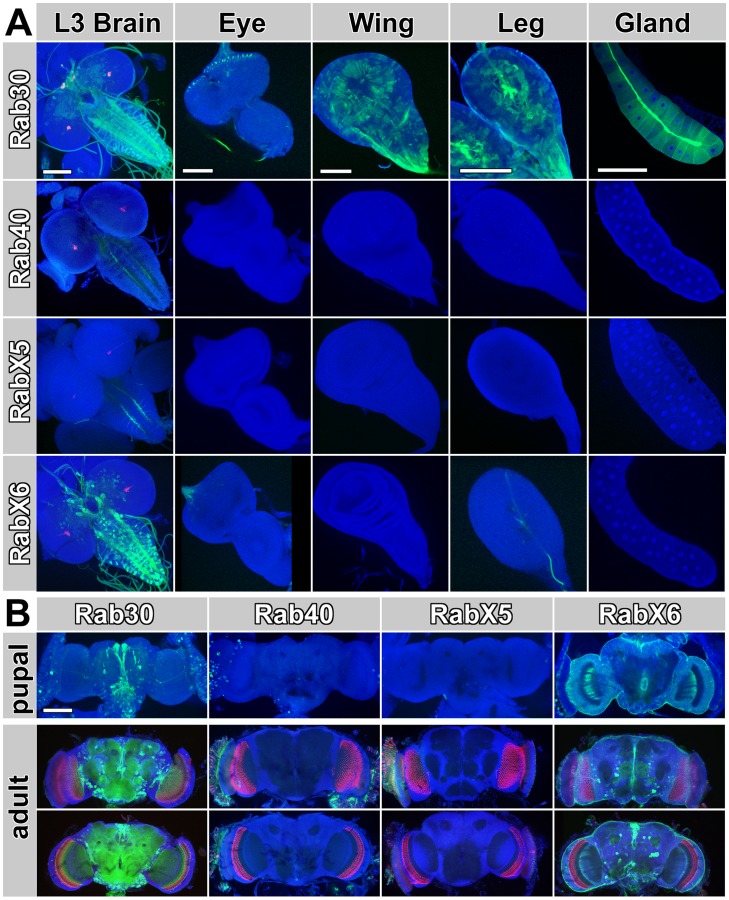
Cellular Expression Analysis of rab30-Gal4, rab40-Gal4, rabX5-gal4 and rabX6-Gal4.All rab-Gal4 lines were crossed to UAS-CD8-GFP. (A) Larval tissues showing GFP expression in green, 3×P3-RFP (positive marker of the Gal4 knock-in cassette) and nuclear Toto3 in blue. (B) Pupal (P+30% +/−5%) and 1-day adult brains (top panel: anterior; bottom panel: posterior. All scale bars represent 100 µm.